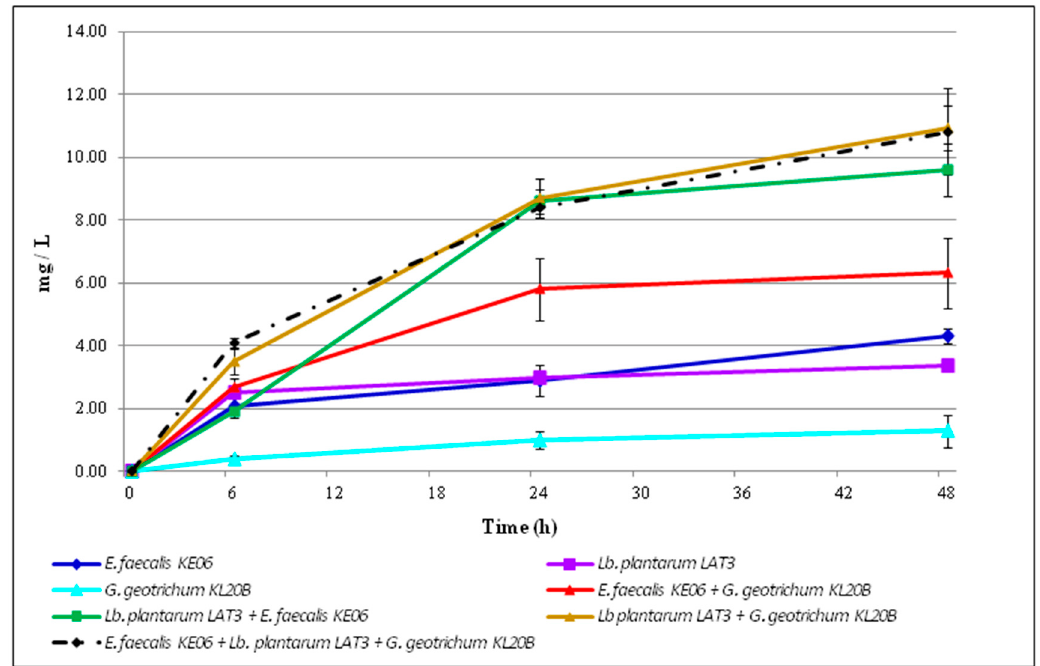
Figure 3. Dynamics of ethanol production during 48 h of fermentation